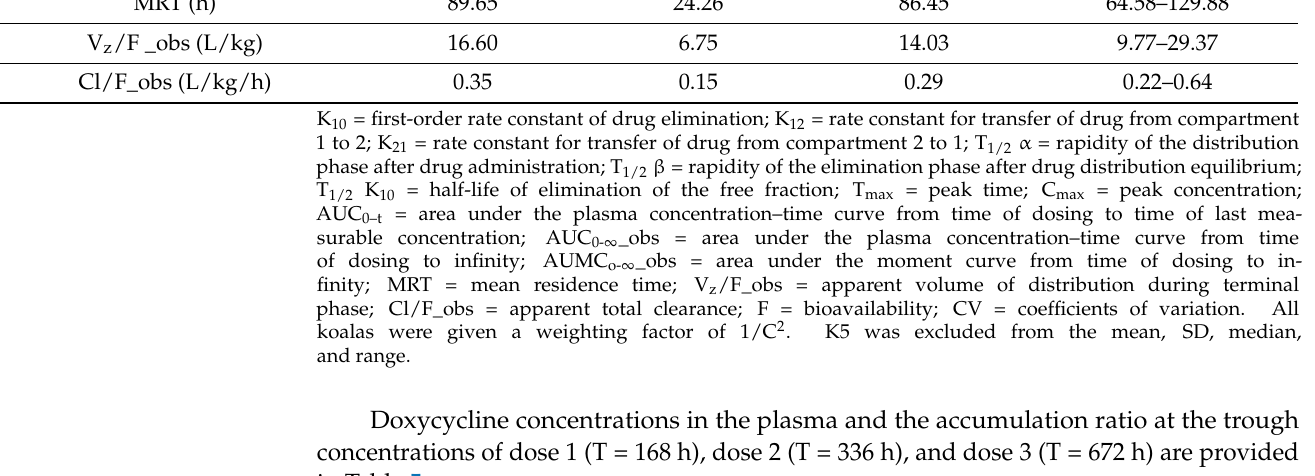
Table 5. Mean ± SD, median, and range of trough doxycycline concentrations in plasma when